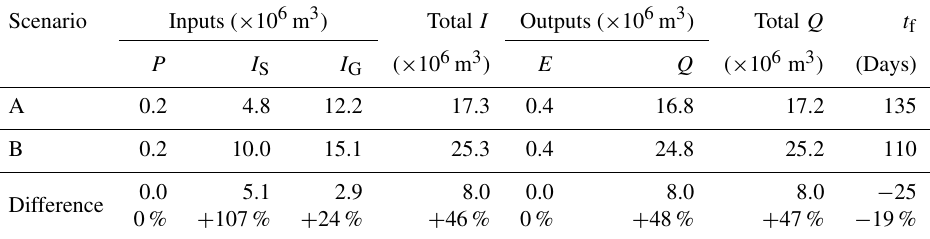
Table 2. Water mass balance of lake A for scenarios A and B. The difference between the total inputs and total outputs corresponds to the lake volume difference over the study period. The total inputs ( I ) correspond to the sum of precipitation ( P ), surface water inflow ( I S ), and groundwater inflow ( I G ). The total outputs ( Q ) correspond to the sum of evaporation ( E ) and surface water and groundwater outflow ( Q ). The mean flushing time ( t f ) is the ratio of the lake volume to the mean groundwater inputs ( I G ). Scenario Inputs ( × 10 6 m 3 ) Total I Outputs ( × 10 6 m 3